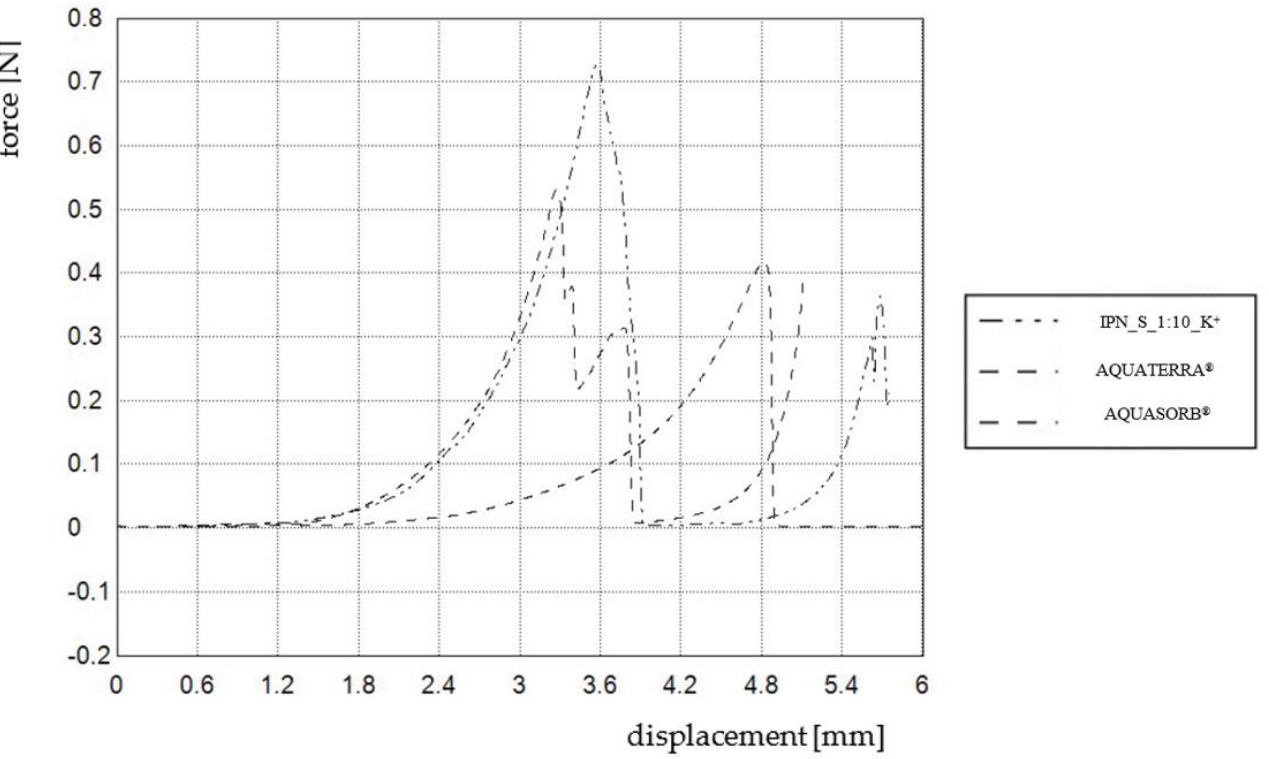
Figure 10. Charts presenting maximal hardness values obtained for three chosen hydrogels.